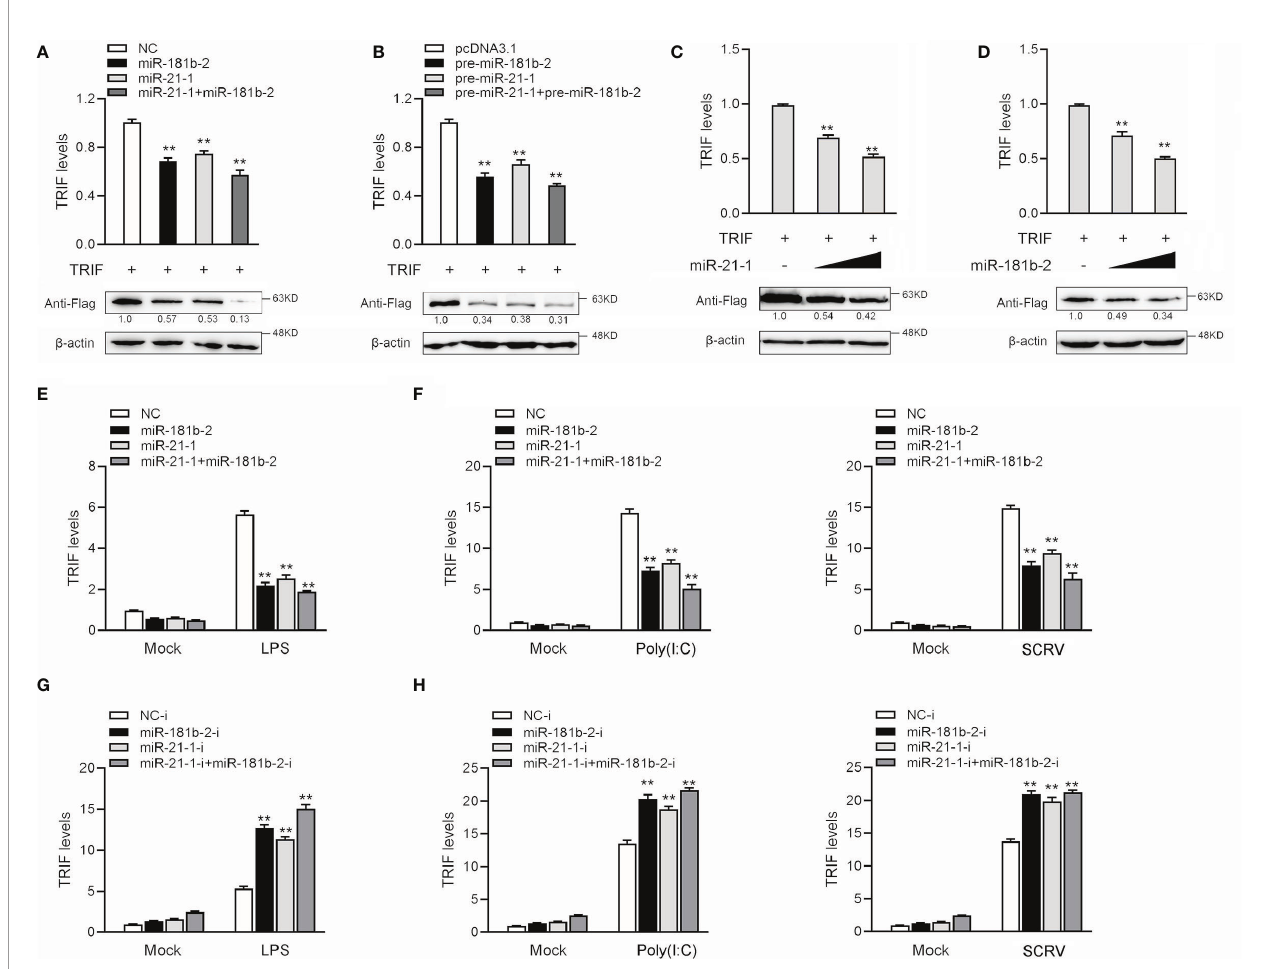
FIGURE 4 | MiR-21-1and miR-181b-2 inhibits the expression of TRIF at post-transcriptional level. (A) HEK293 cells were cotransfected with TRIF expression plasmid with NC, miR-21-1 or miR-181b-2. After 48 h, TRIF protein and mRNA levels were determined by Western blotting and qRT-PCR, respectively. (B) HEK293 cells were cotransfected with TRIF expression plasmid with pcDNA3.1, pre-miR-21-1 or pre-miR-181b-2. After 48 h, TRIF protein and mRNA levels were determined by Western blotting and qRT-PCR, respectively. (C, D) HEK293 cells were cotransfected with TRIF expression plasmid, along with NC, miR-21-1 (C) (0, 50, and 100 nM) or miR-181b-2 (D) (0, 50, and 100 nM) in a concentration gradient manner, and NC was used to control the same amounts of molecules for transfections. After 48 h, TRIF protein and mRNA levels were determined by western blotting and qRT-PCR, respectively. (E) We transfected miR-21-1 and miR-181b-2 into MBrC cells, NC as negative control, and stimulated with LPS for 6 h, and the TRIF mRNA expression were determined by qRT-PCR. (F) miR-21-1 and miR-181b-2 were transfected into MBrC cells, NC as negative control, and stimulated with poly(I:C) for 12 h or SCRV injection for 12 h, and the TRIF mRNA expression were determined by qRT-PCR. (G) We transfected miR-21-1-i and miR-181b-2-i into MBrC cells, NC-i as negative control, and stimulated with LPS for 6 h, and the TRIF mRNA expression were determined by qRT-PCR. (H) miR-21-1-i and miR-181b-2-i were transfected into MBrC cells, NC-i as negative control, and stimulated with poly(I:C) for 12 h or SCRV injection for 12 h, and the TRIF mRNA expression were determined by qRT-PCR. All data are presented as the means ± SE from three independent triplicate experiments. ** p < 0.01, versus the